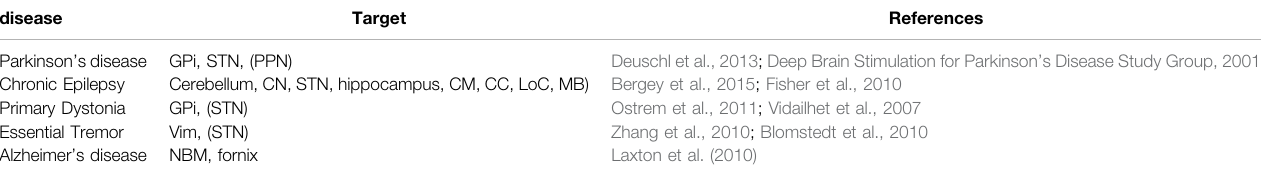
TABLE 1 | Chronic diseases and corresponding DBS target sites. disease